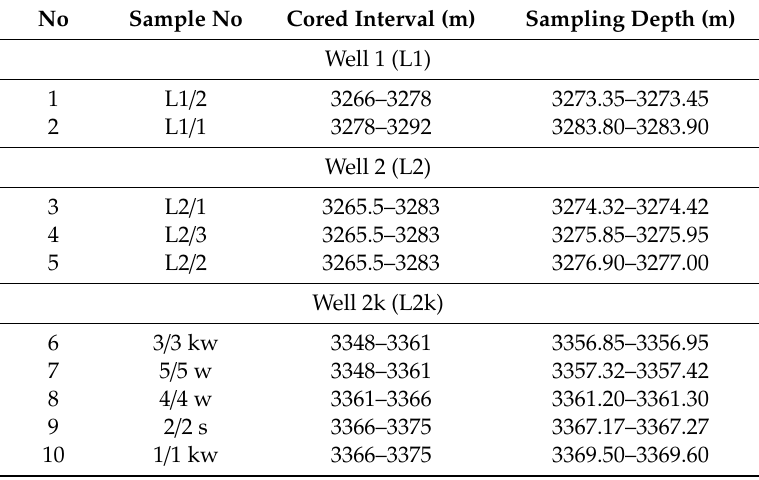
Table 1. Summary of the